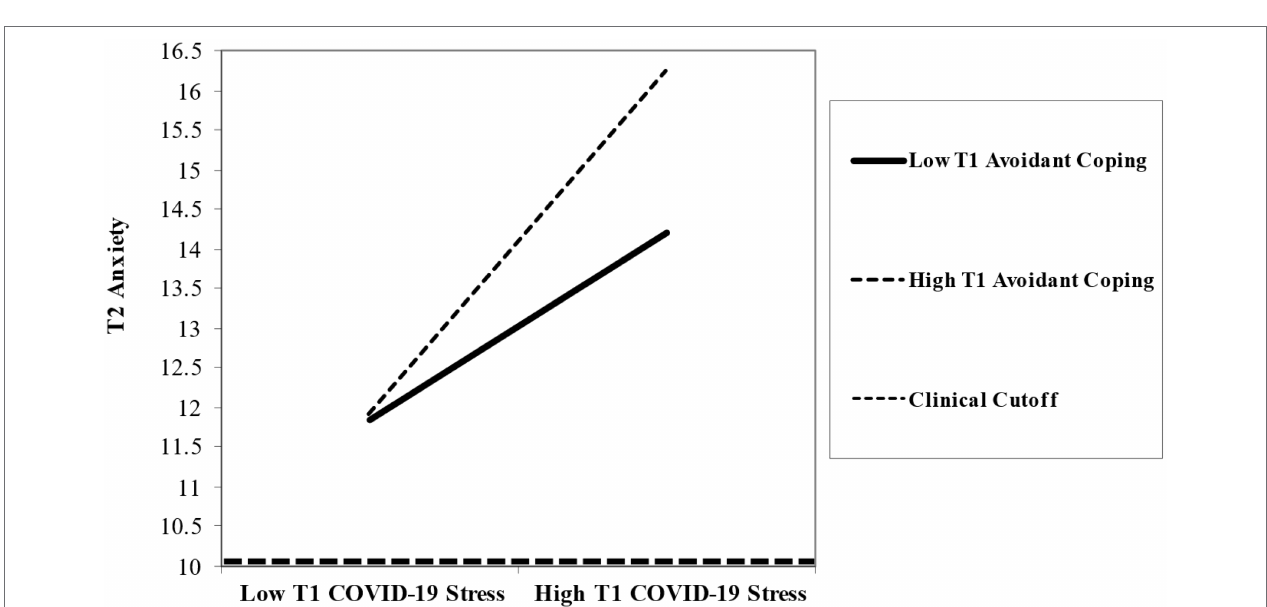
FIGURE 4 | Interaction between COVID-19 stress and avoidant coping predicting later